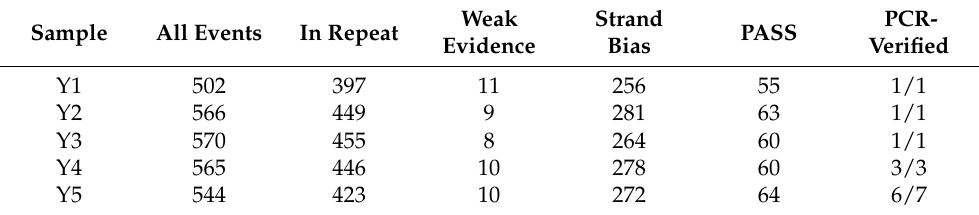
Table 2. Number of transposable element (TE) insertion events reported by TEfinder in evolved populations of